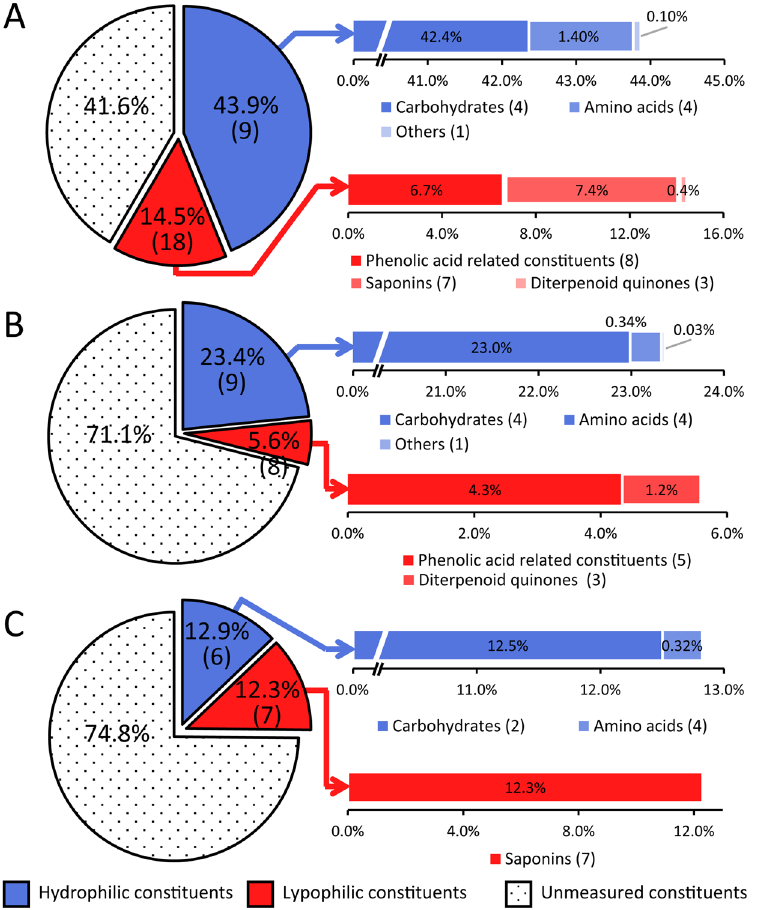
Figure 6. Results of 27 analytes in Dan-Qi Pair extract ( A ), Radix Salvia miltiorrhiza ( B ), and Radix Panax notoginseng ( C ) using the directly-coupled RP-HILIC-MS/MS system. Average contents of analytes are presented by weight percent. Percentages refer to average contents (by weight percent) in all determined samples. Numbers in the brackets refer to numbers of determined